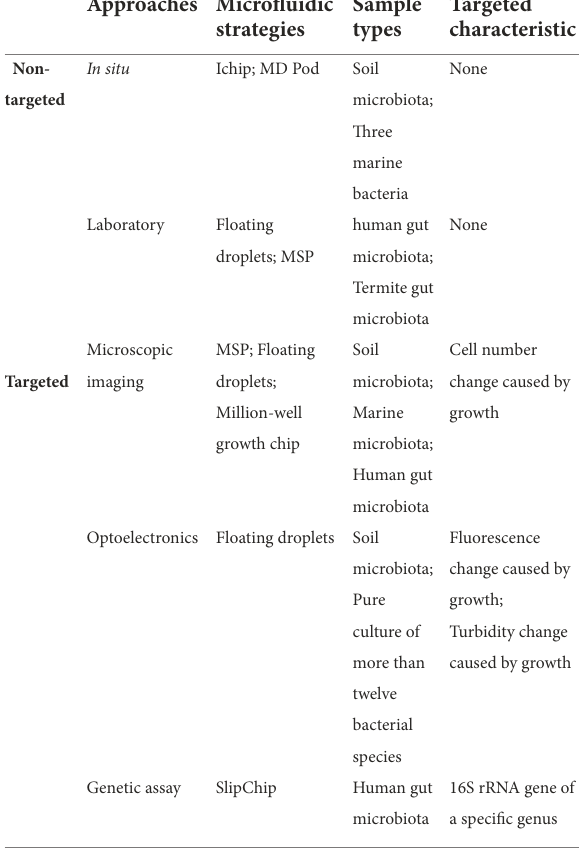
TABLE 2 A brief summary of different microfluidic strategies for non- targeted and targeted taxa discovery and isolation approaches. Approaches Microfluidic